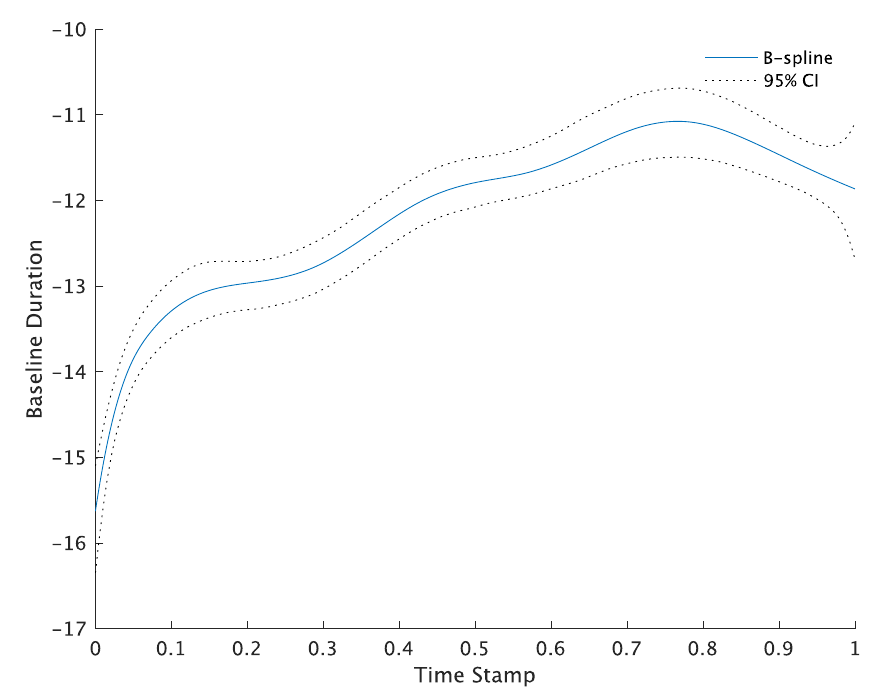
Figure 9. Intraday seasonality of time interval of JAL, Tokyo, Japan (27 July